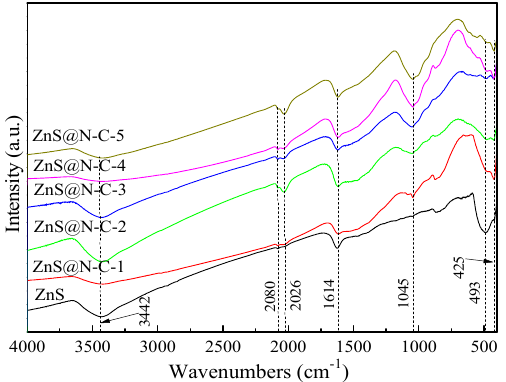
Figure 5. Fourier Transform infrared spectroscopy (FT-IR) spectra of ZnS and ZnS@N-C composites.